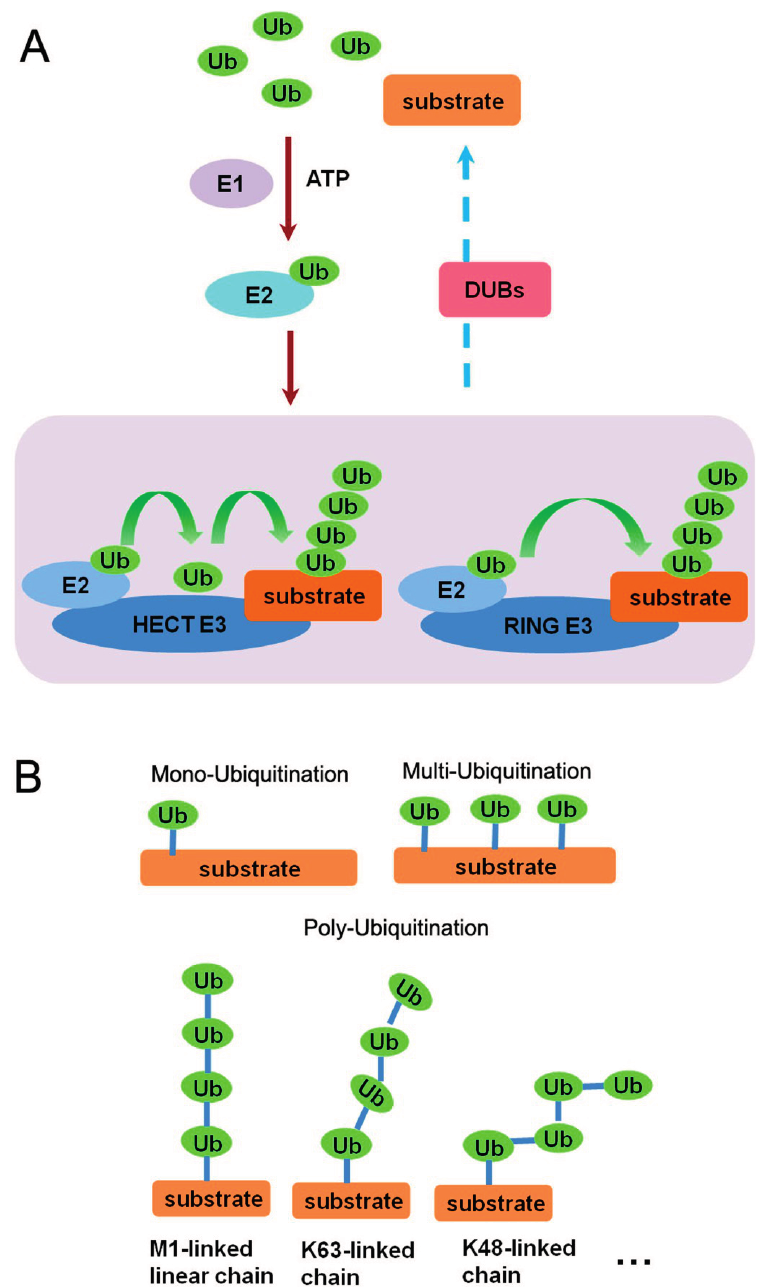
Figure 1. ( A ) Schematic representation of the ubiquitination procedure by E1, E2, and E3 enzymes; ( B ) Schematic representation of different ubiquitination patterns,